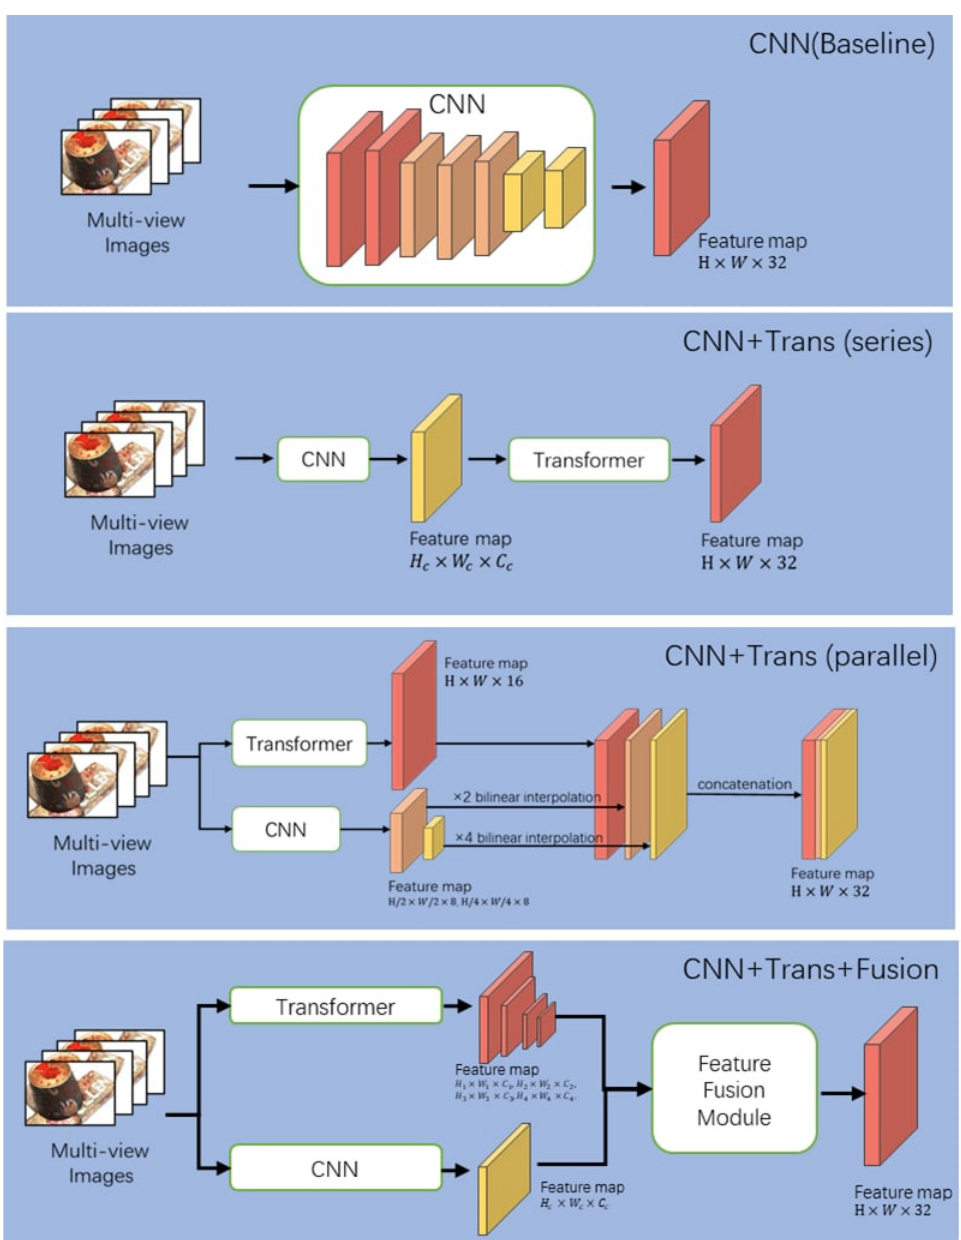
Figure 7. Schematic diagram of the ablation study network framework.